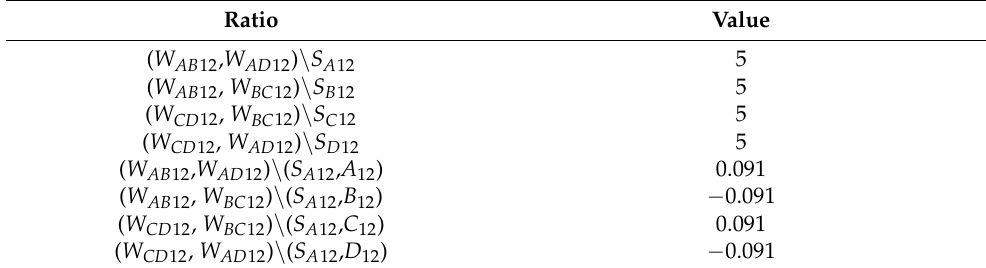
Table 4. The data defining the mesh B v 12 .